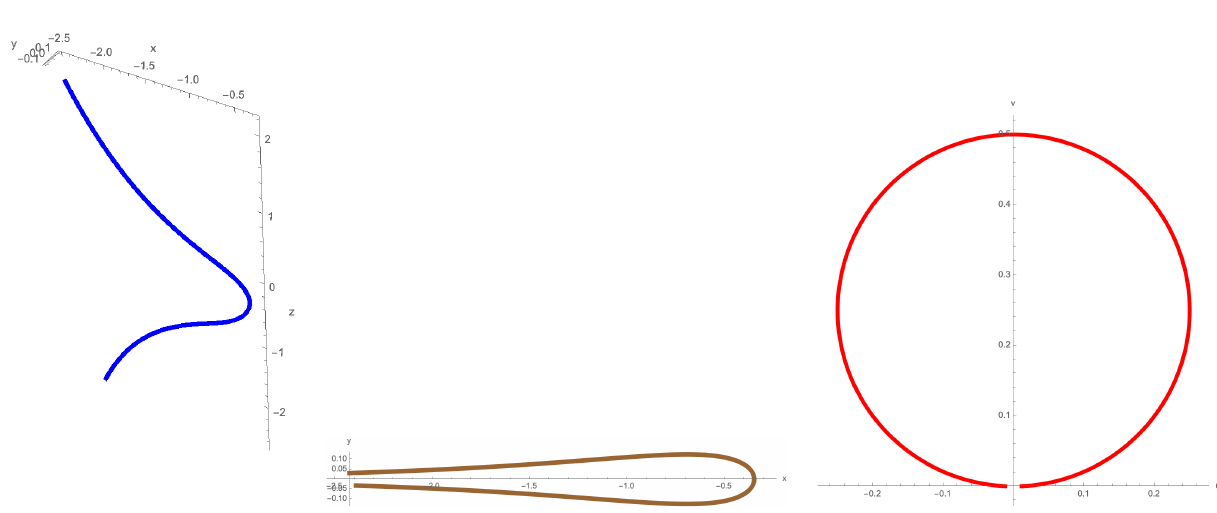
Figure 2. α = 2, ε = 1, q =